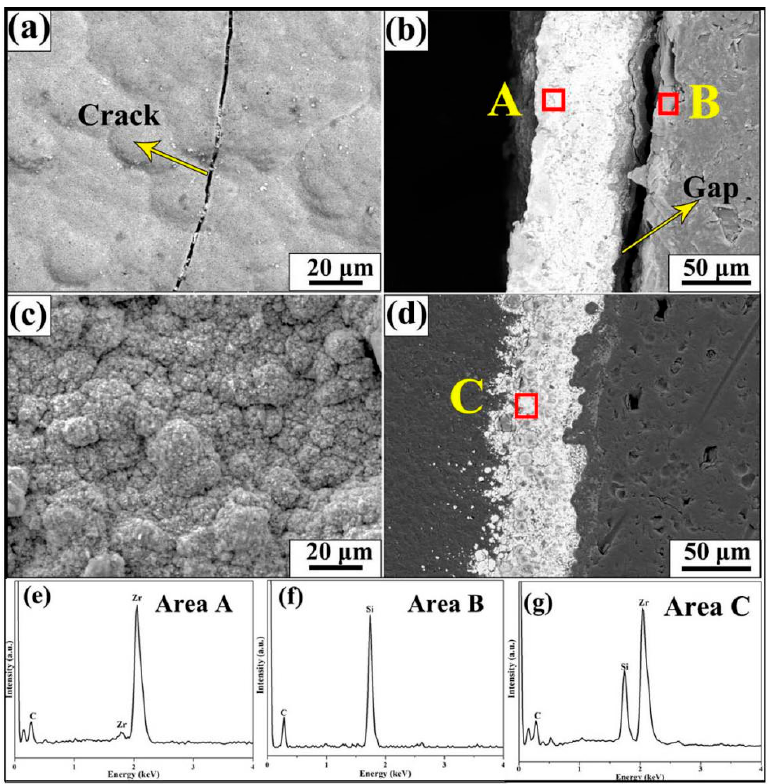
Figure 3. The surface morphology of ZrC/SiC coating ( a ) and ZrC-SiC coating ( c ); the cross-section of ZrC/SiC coating ( b ) and ZrC-SiC coating ( d ); the electron spectroscopy (EDS) results of Area A ( e ), Area B ( f ) and Area C ( g ).